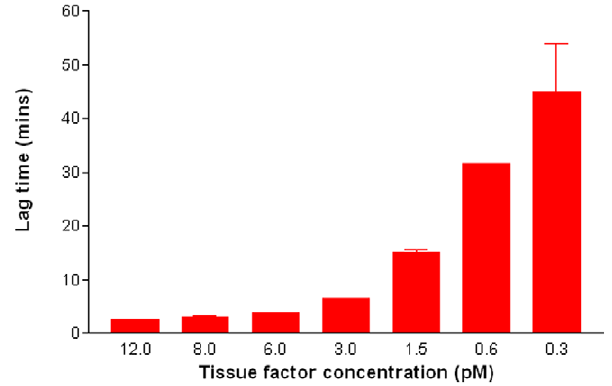
Figure 1. The effect of STBM on thrombin generation parameters of normal platelet poor plasma. (A) STBM were added to platelet poor plasma at a concentration 50 m g/mL. Following the addition of 4 m M phospholipid and 16 nM CaCl 2 , thrombin generation was monitored continuously. Endogenous thrombin potential (ETP), time to start of thrombin generation, peak thrombin generation and time to peak thrombin generation are shown for normal STBM and pre-eclampsia STBM (PET). (B) This was repeated after prior incubation with 25 m g/mL anti-TFPI and (C)